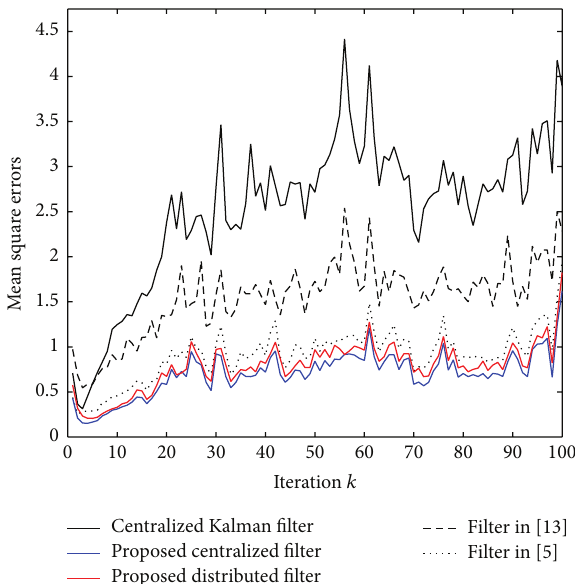
Figure 4: Mean square errors, when 𝑝 (3) = 0.5 , 𝑝 (4) = 0.75